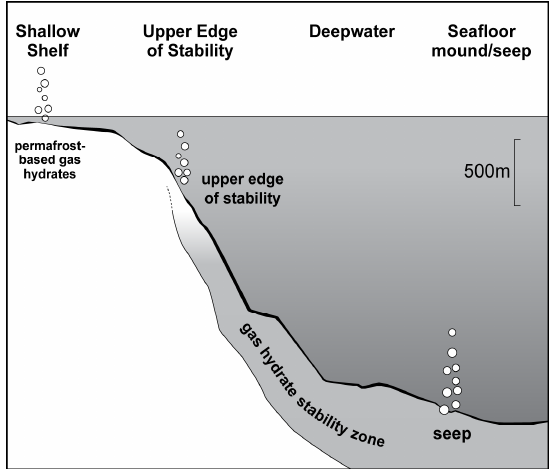
Figure 1. Generalized scheme of marine gas hydrate (GH) stability from onshore permafrost settings to the continental slope (simplified and adapted from